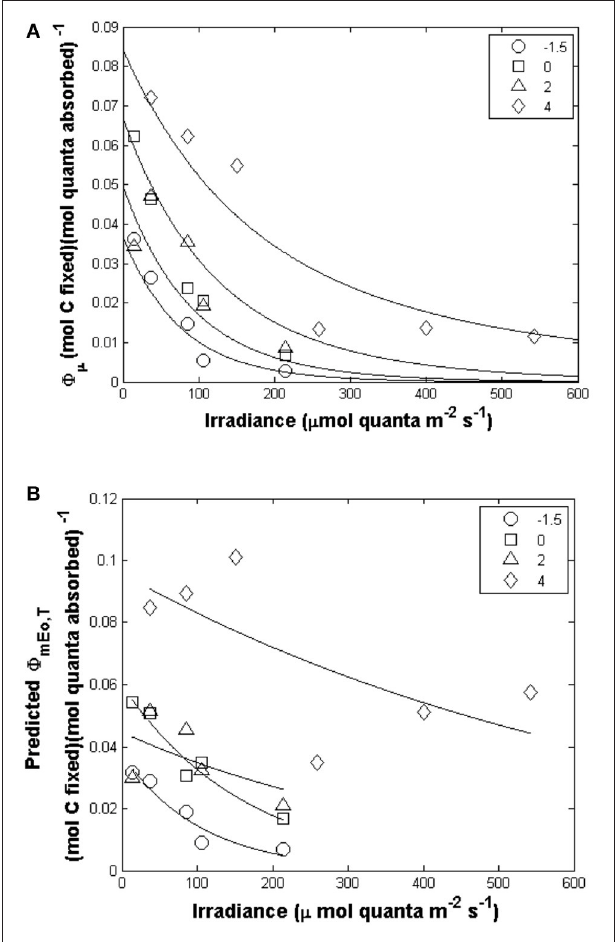
FIGURE 4 | (A) Light and temperature dependence of φ µ (mol C (mol quanta absorbed) − 1 ) for P. antarctica (symbols). Our modeled φ µ relationship with light and temperature (solid line) is calculated with a constant E k µ and a modeled φ mEo,T (Equation 6). (B) φ mEo,T response to different temperature and irradiance treatments (Symbols are experimental observations, lines are model predictions). A fixed E k µ value was used to calculate φ mEo,T